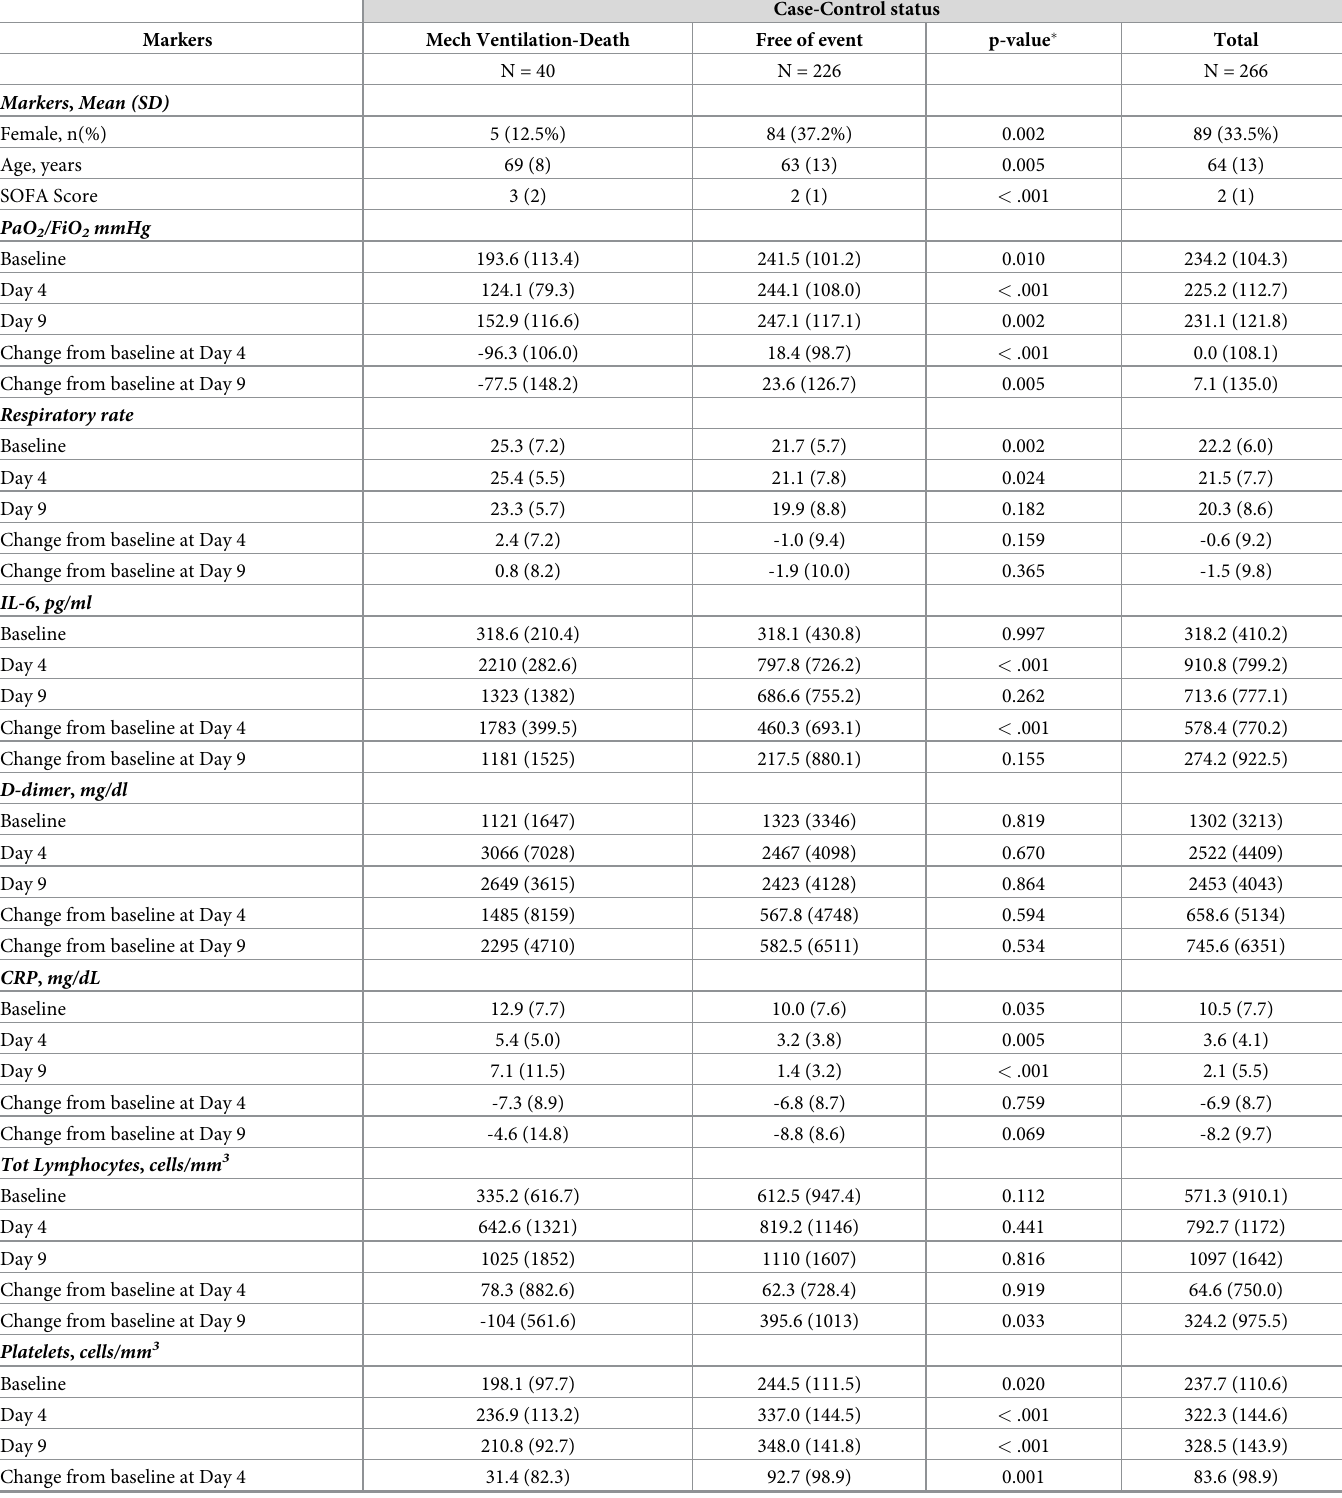
Table 1. Mean of biomarkers by case-control